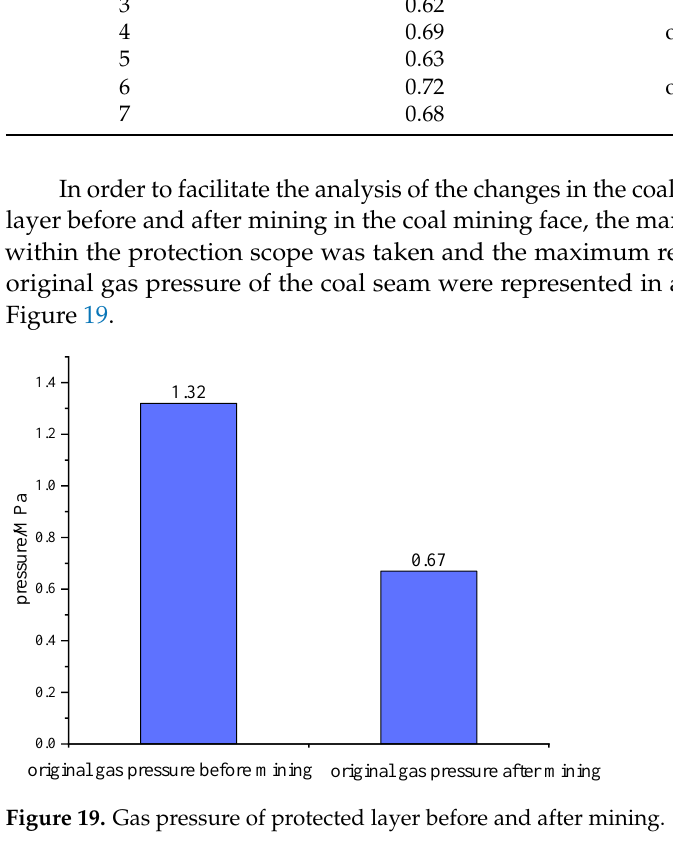
Figure 19. Gas pressure of protected layer before and after mining.